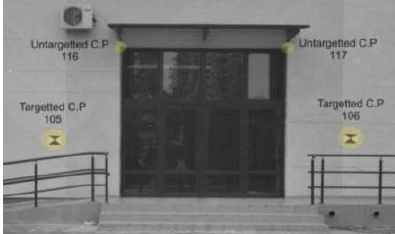
Figure 1. Building ground plan, the traverse scheme and the base lines for raw image acquisition From the network points, the stereoscopic base lines points were ground marked (twenty camera positions) and more than 60 artificial control points (targeted points) placed on the building facade were measured with Leica TC(R) 405 total station reflector less measurement. An example of natural and artificial points is shown in Figure 2.